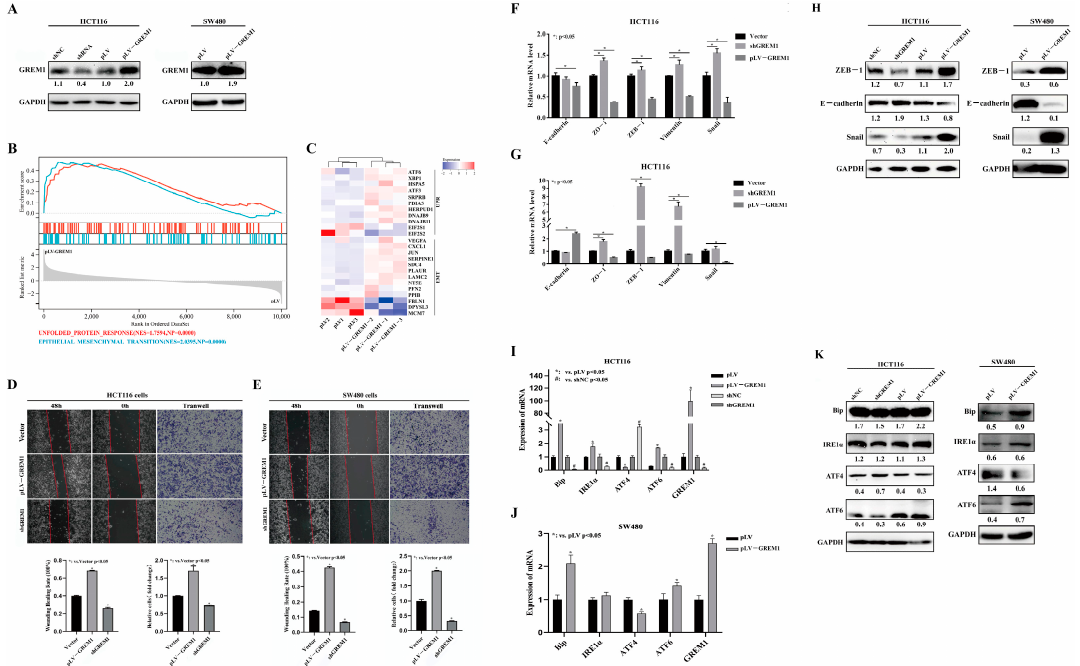
Figure 2. GREM1 expression promotes cell invasion and migration of HCT116 and SW480 cells and ER stress. ( A ) Overexpression or underexpression of GREM1 was detected by Western blotting. ( B ) GSEA was performed using our RNA-seq dataset to identify sets of hallmark genes that were positively associated with GREM1 expression. Enrichment plots showed EMT (NES = 2.0395, NP = 0.0000) and UPR (NES = 1.7594, NP = 0.0000). ( C ) The heatmap showed signature genes involving EMT and UPR. ( D , E ) Wound healing test and Boyden chambers with Matrigel revealed that GREM1 overexpression promoted HCT116 and SW480 cell migration and invasion. ( F – H ) Cells were analyzed after harvesting, for protein and mRNA expression. qRT-PCR and Western blotting analysis showed expression of mRNA and proteins involved in EMT. ( I – K ) qRT-PCR and Western blotting results showed the expression of proteins and mRNA that were involved in UPR and ER